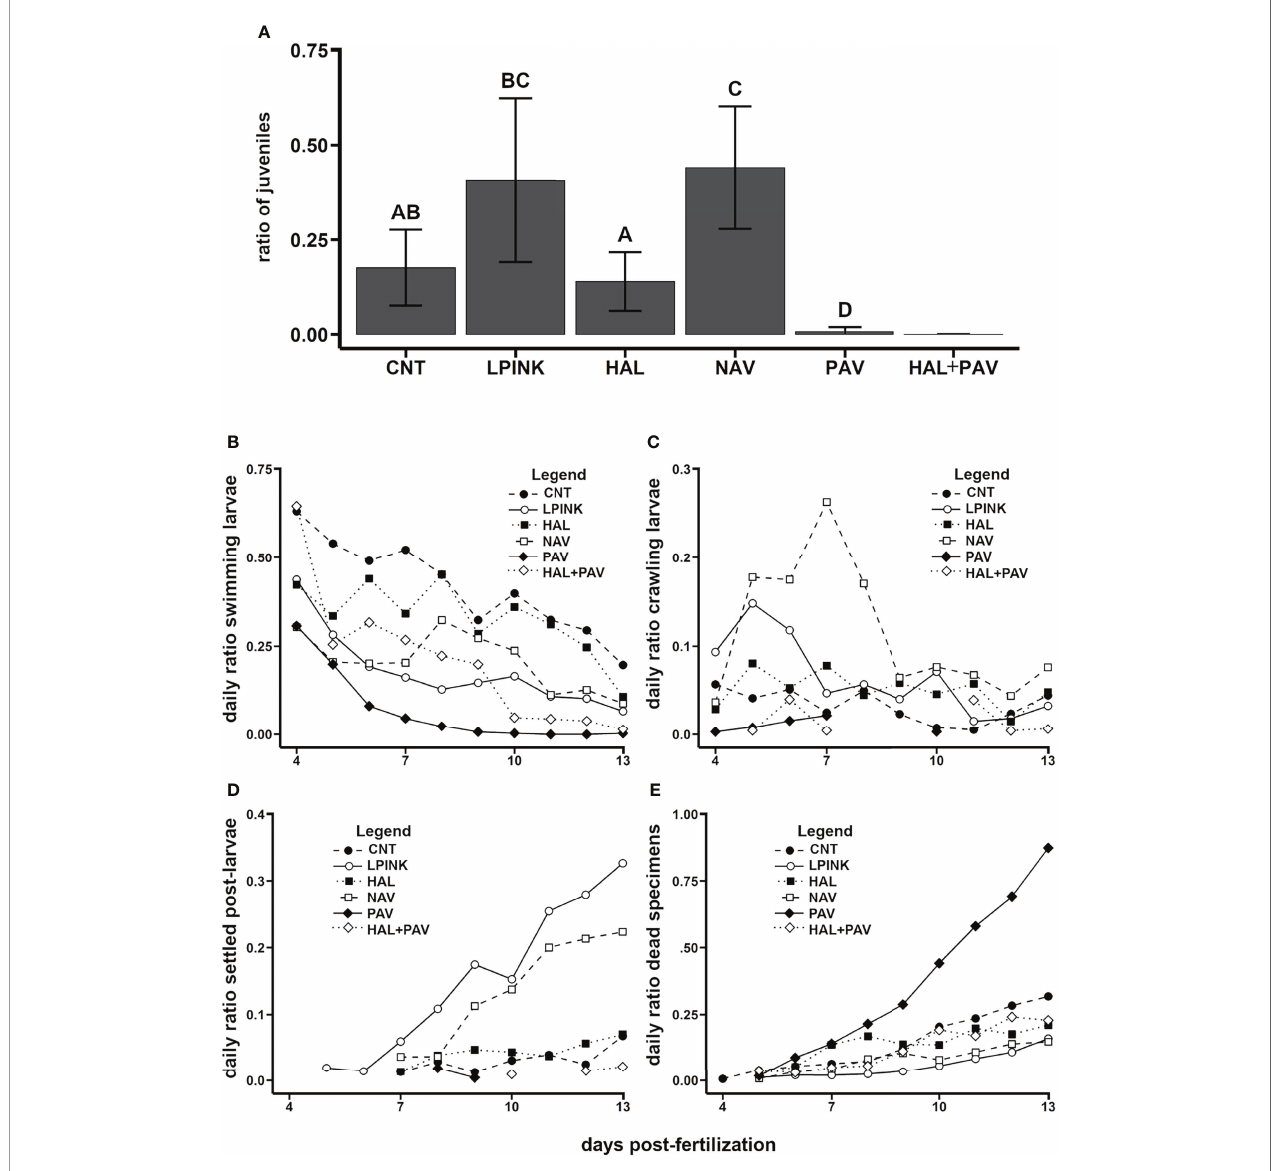
FIGURE 11 | P. candei . In fl uence of different cultured algal strains and encrusting coralline algae on the settlement (study realized in Madeira). Ratio of juveniles obtained at the end of the assay, bars indicate average ± SD and different letters indicate signi fi cant differences ( p < 0.01) (A) . Daily average ratio: swimming (B) and crawling pediveligers (C) , settled specimens (early post-larvae + juveniles) (D) and dead specimens (empty shells) (E) . CNT, negative control treatment; HAL, diatom Halamphora coffeaeformis bio fi lm; HAL+PAV, combination of the treatments HAL and PAV; LPINK, coralline algae formed by light pink crusts; NAV, diatom Navicula incerta bio fi lm; PAV, free swimming algae Pavlova